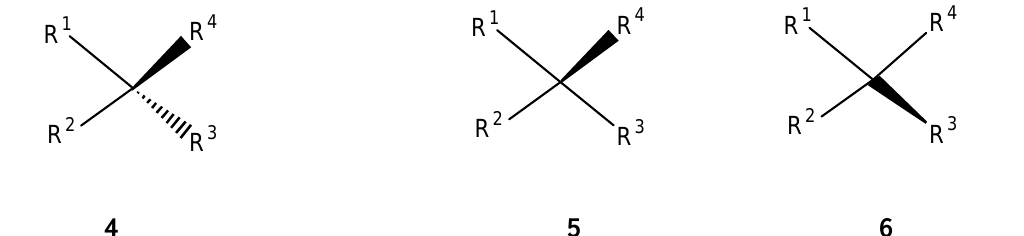
Figure 14. Stereochemical representation with false mirror symmetry in structure 4 : Both wedges have the thick ends at R 3 and R 4 placed identically away from the center [35]. The one-wedge representation ( 5 or 6 ) offers unambiguity and esthetic appeal